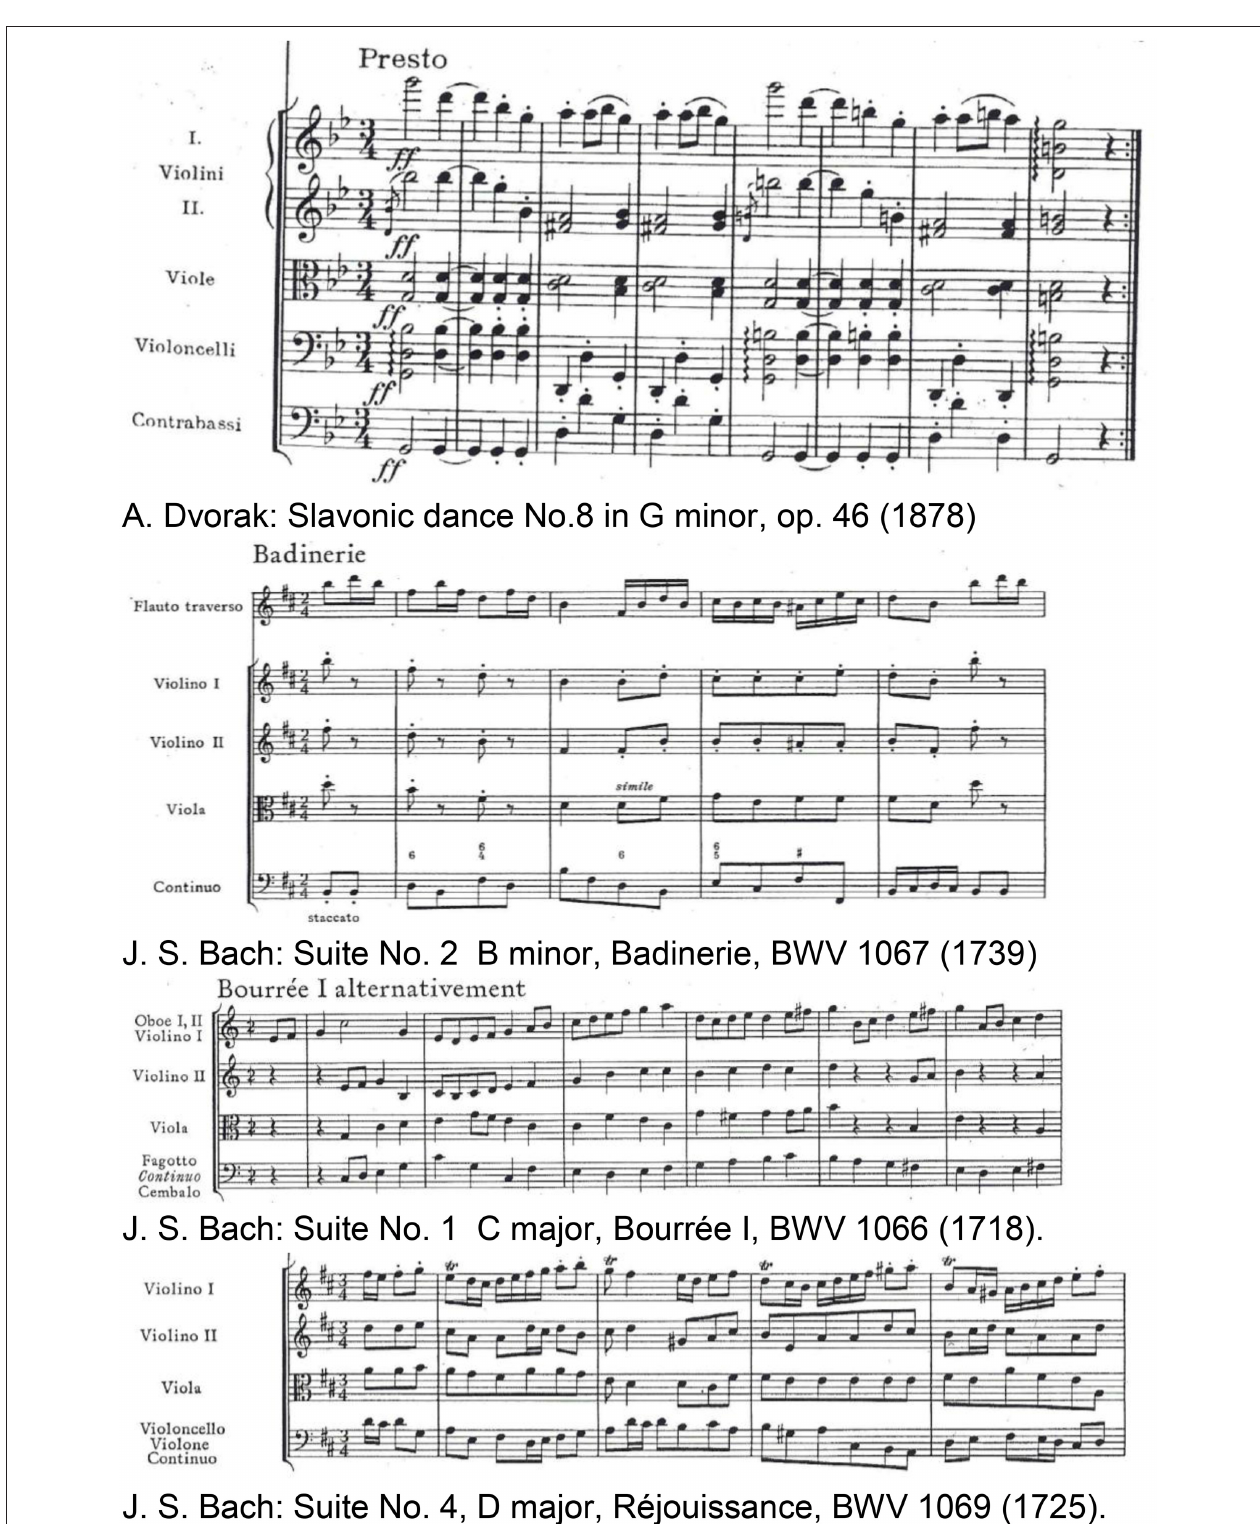
FIGURE 8 | Joyful instrumental dance-tunes of major-minor tonal music by Dvorak (1955) and Bach (1967) used from commercially available CDs as pleasant stimuli in Koelsch et al. (2006). Reprinted with permission from Bach (1967) © 1967 Bärenreiter.